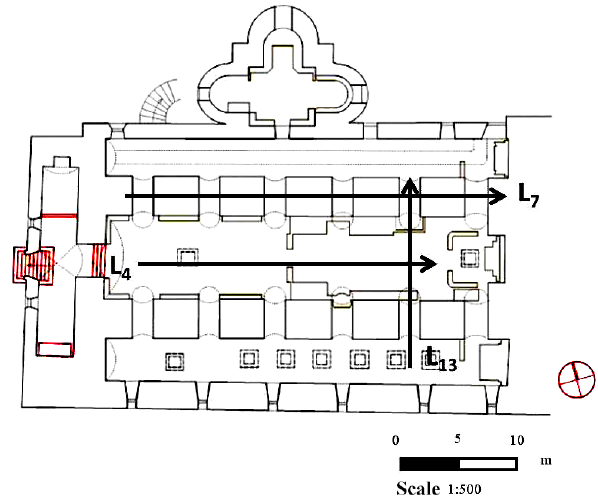
Figure 4. Map of the Church of Santa Croce, with the projections of the layouts of the B-scans L 4 , L 7 and L 13 gathered on the floor of the Cathedral of Santa Maria